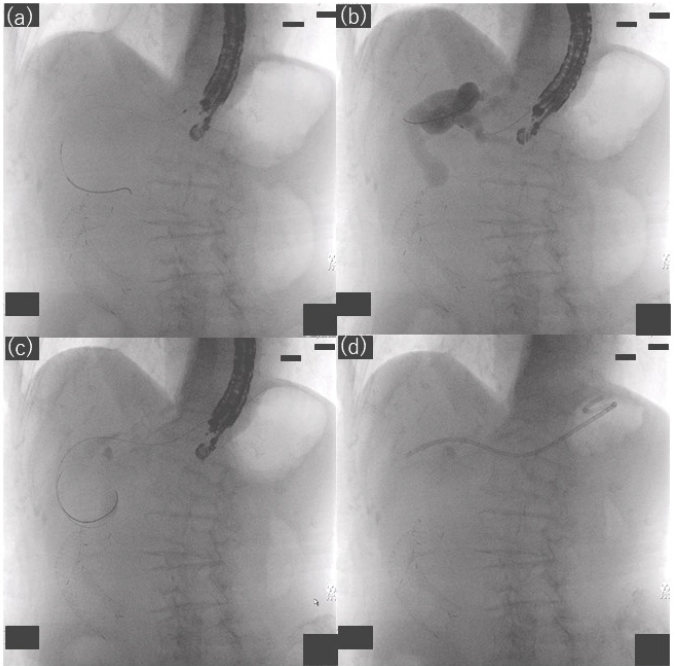
Figure 4. Fluoroscopic images showing hepaticogastrostomy. ( a ) Bile duct puncture and guidewire passage, ( b ) track dilation and cholangiography with an ERCP contrast catheter, ( c ) bile aspiration with an ERCP contrast catheter, ( d ) stent placement.